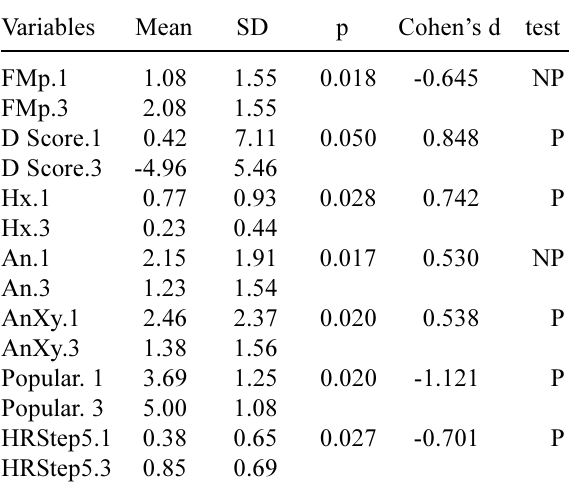
Statistics of the Rorschach Significant Variables on